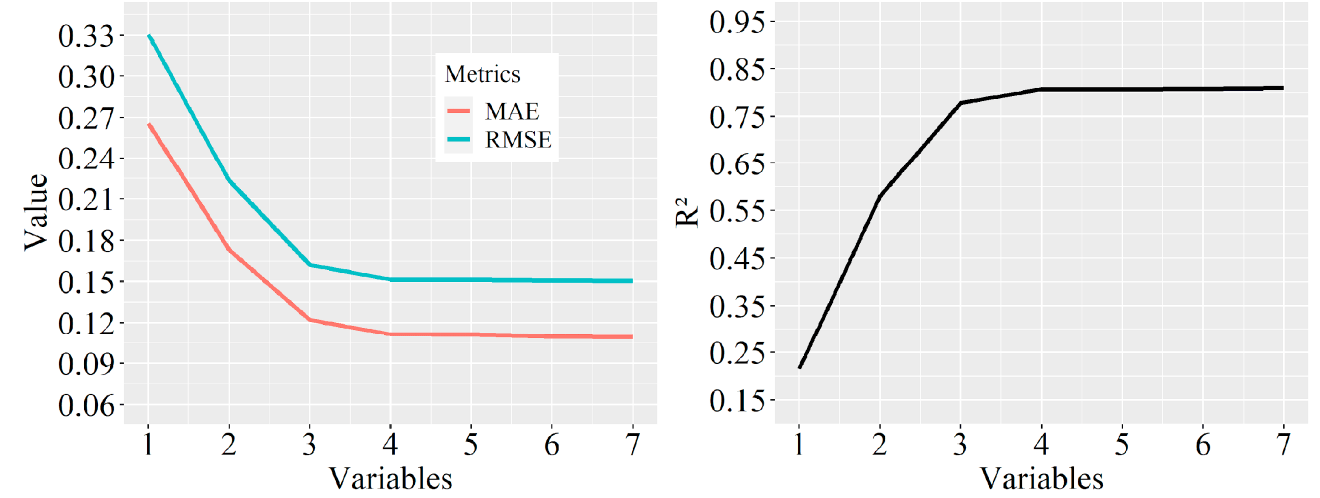
Figure 4. Statistical results for the selection of predictor variables when applying the RFE in approach 1. In approach 2, the number of predictors generated by normalizing the bands is 45, higher than in approach 1 because of the bigger number of spectral bands for the special resolution of 20 m. When establishing the baseline of 95% of correlation, 22 variables remained and were later reduced to 12 after the application of the RFE. Figure 5 shows the stability of the statistical metrics using 12 predictable variables to train the model.